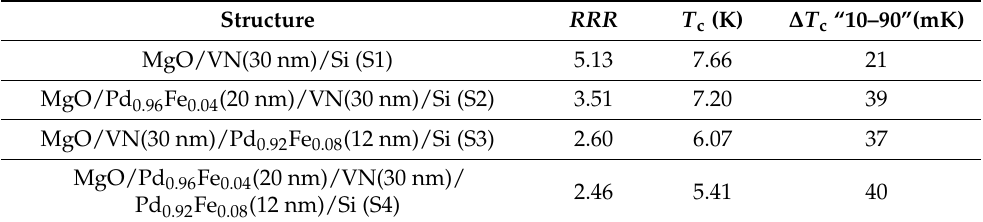
Table 1. Electrical and superconducting properties of heteroepitaxial Structures S1–S4 on MgO(001).